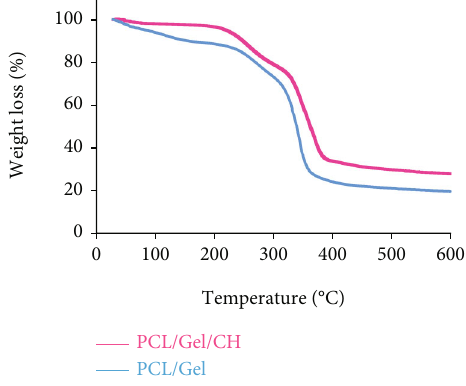
Figure 2: Thermogravimetric analysis (TGA) curves of PCL/Gel with and without